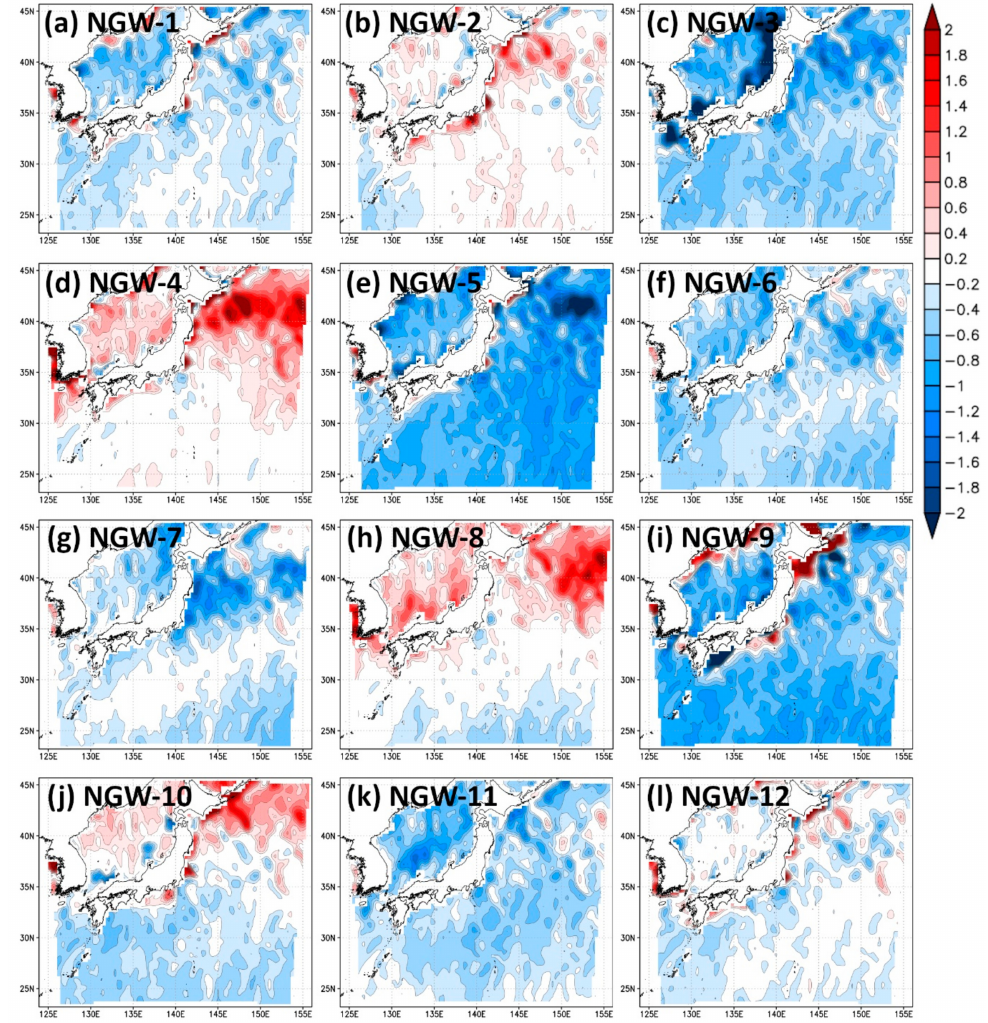
Figure 12. Di ff erence in sea surface temperature (SST) under initial conditions between each NGW simulation and the hindcast. Result of ( a ) NGW-1, ( b ) NGW-2, ( c ) NGW-3, ( d ) NGW-4, ( e ) NGW-5, ( f ) NGW-6, ( g ) NGW-7, ( h ) NGW-8, ( i ) NGW-9, ( j ) NGW-10, ( k ) NGW-11, ( l ) NGW-12. The unit of the color bar is